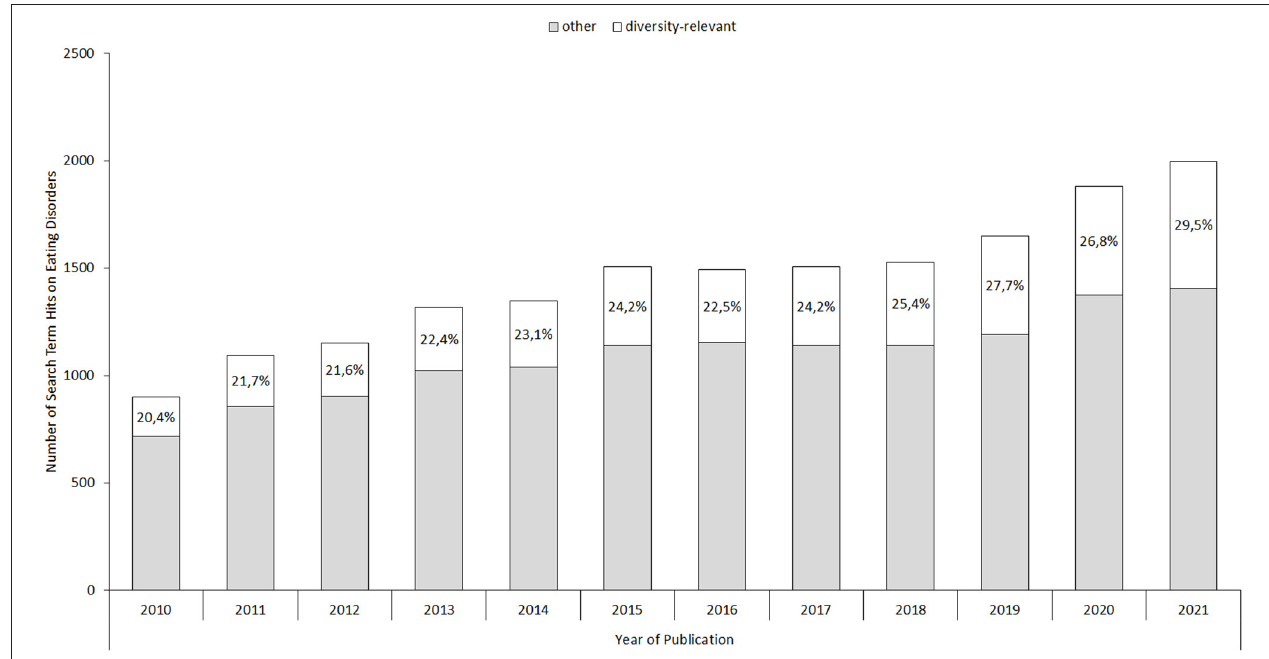
FIGURE 1 | Illustration of the number of yearly total ED publications and potentially diversity-relevant ED publications. Percentages indicate the proportion of diversity-relevant among total yearly ED